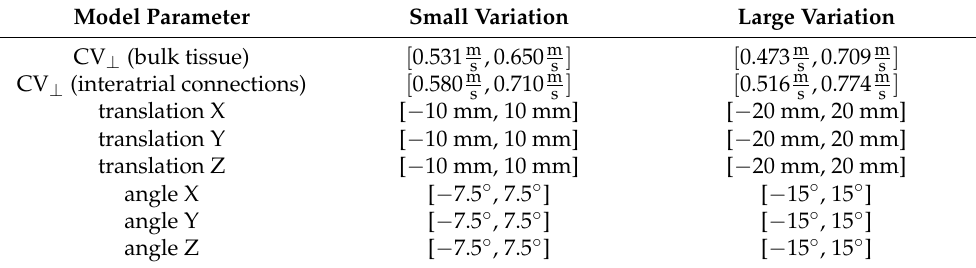
Table 1. Model parameters and intervals to sample from for generating the datasets with small and large parameter